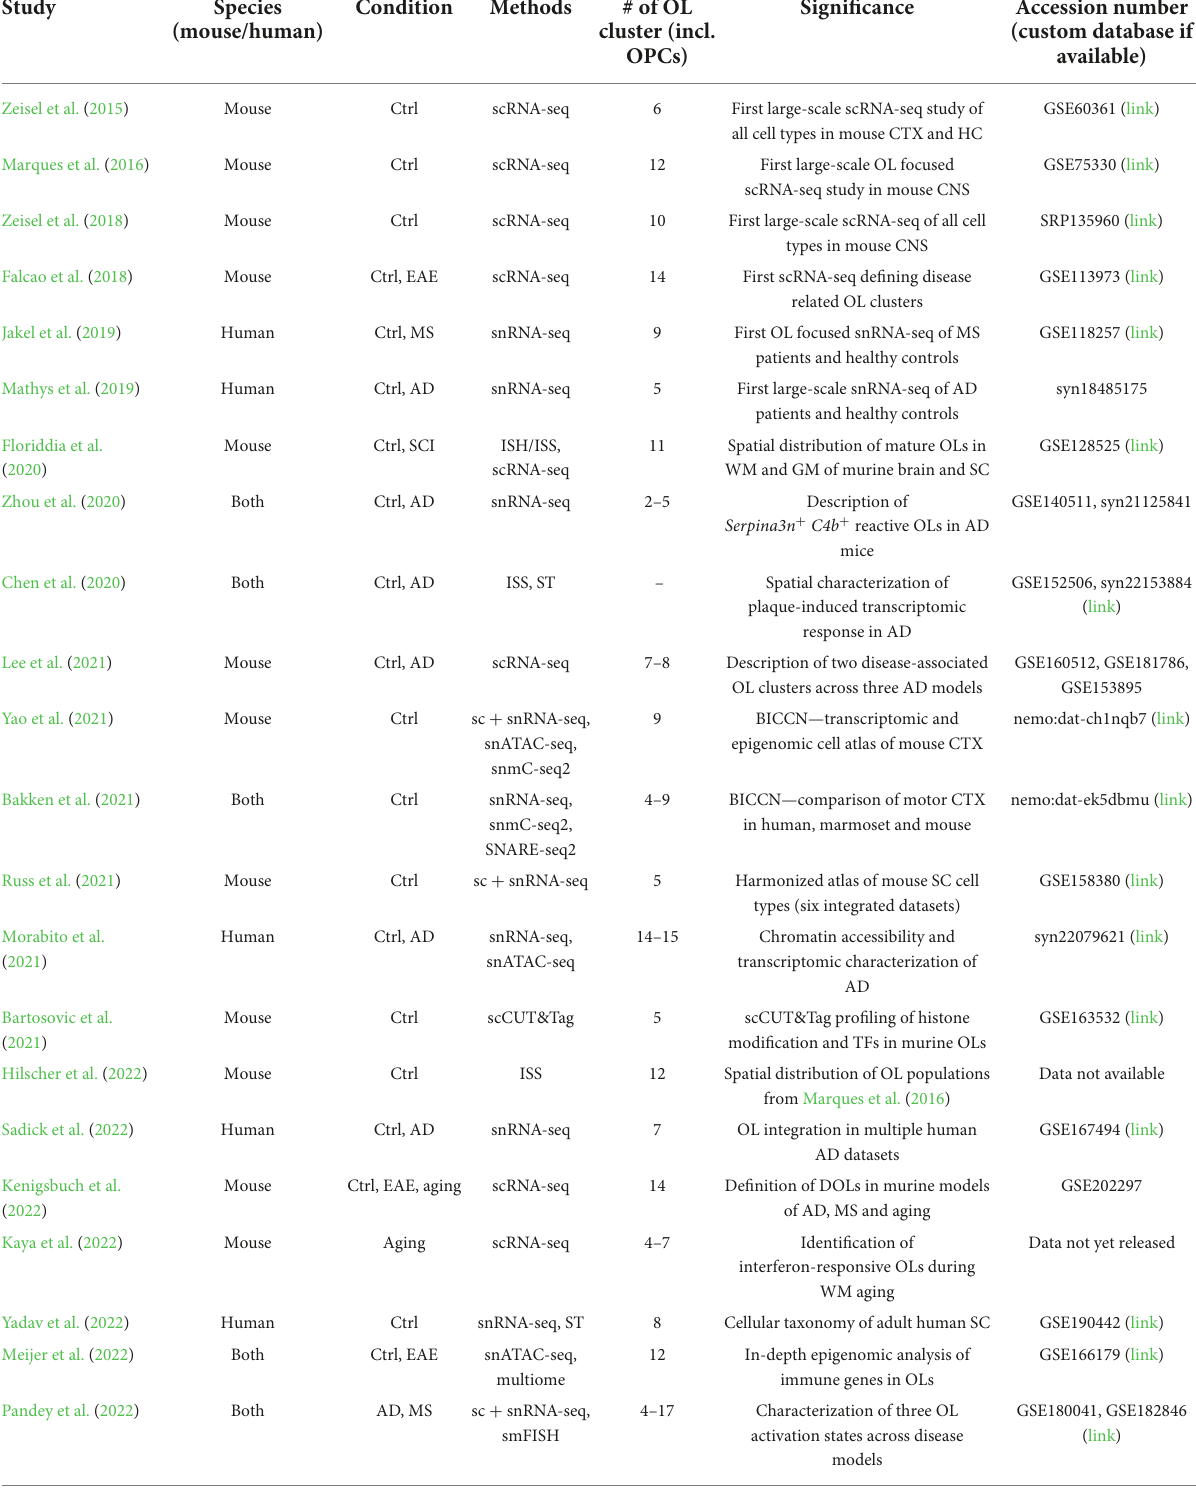
TABLE 1 Selection of key transcriptomic studies for understanding OL heterogeneity in health and